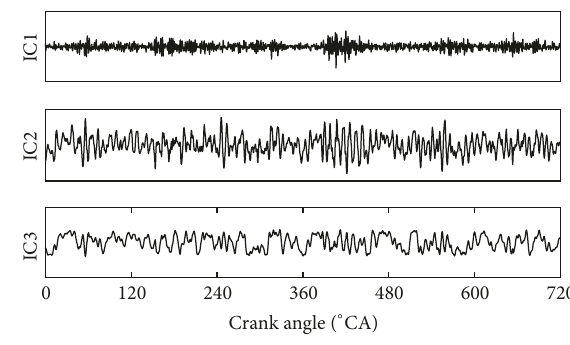
Figure 20: Calculation results by the RobustICA.